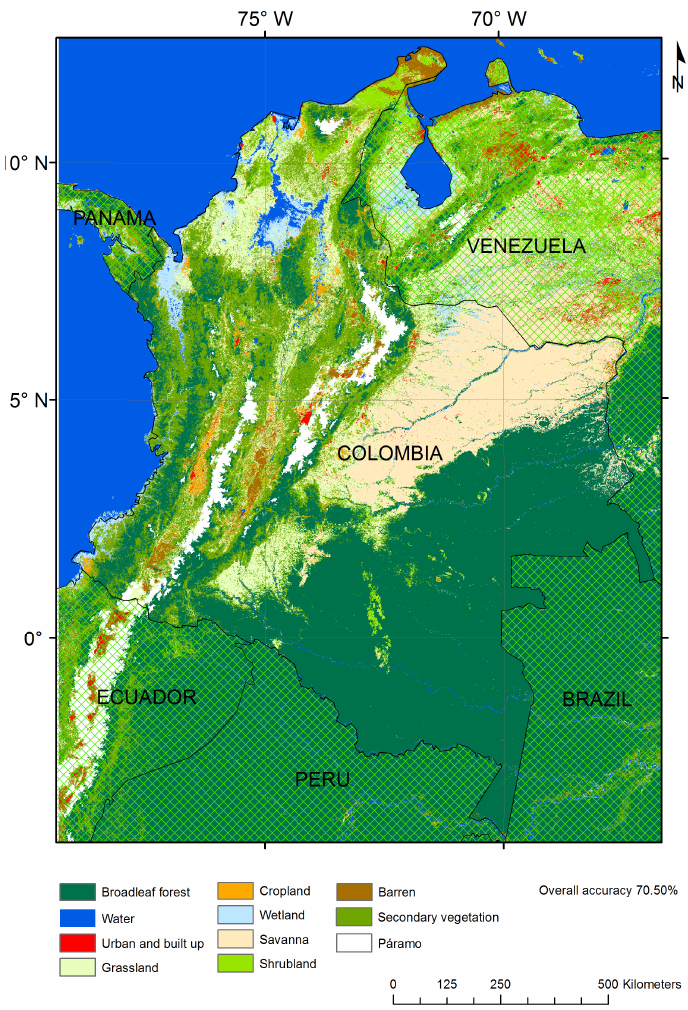
Figure 7. Land cover map for Colombia using 2011 ± 2 years of MODIS NDVI and surface reflectance MOD13A1 data, filtered for low-quality observations and adding elevation (TS-F-C2-E).